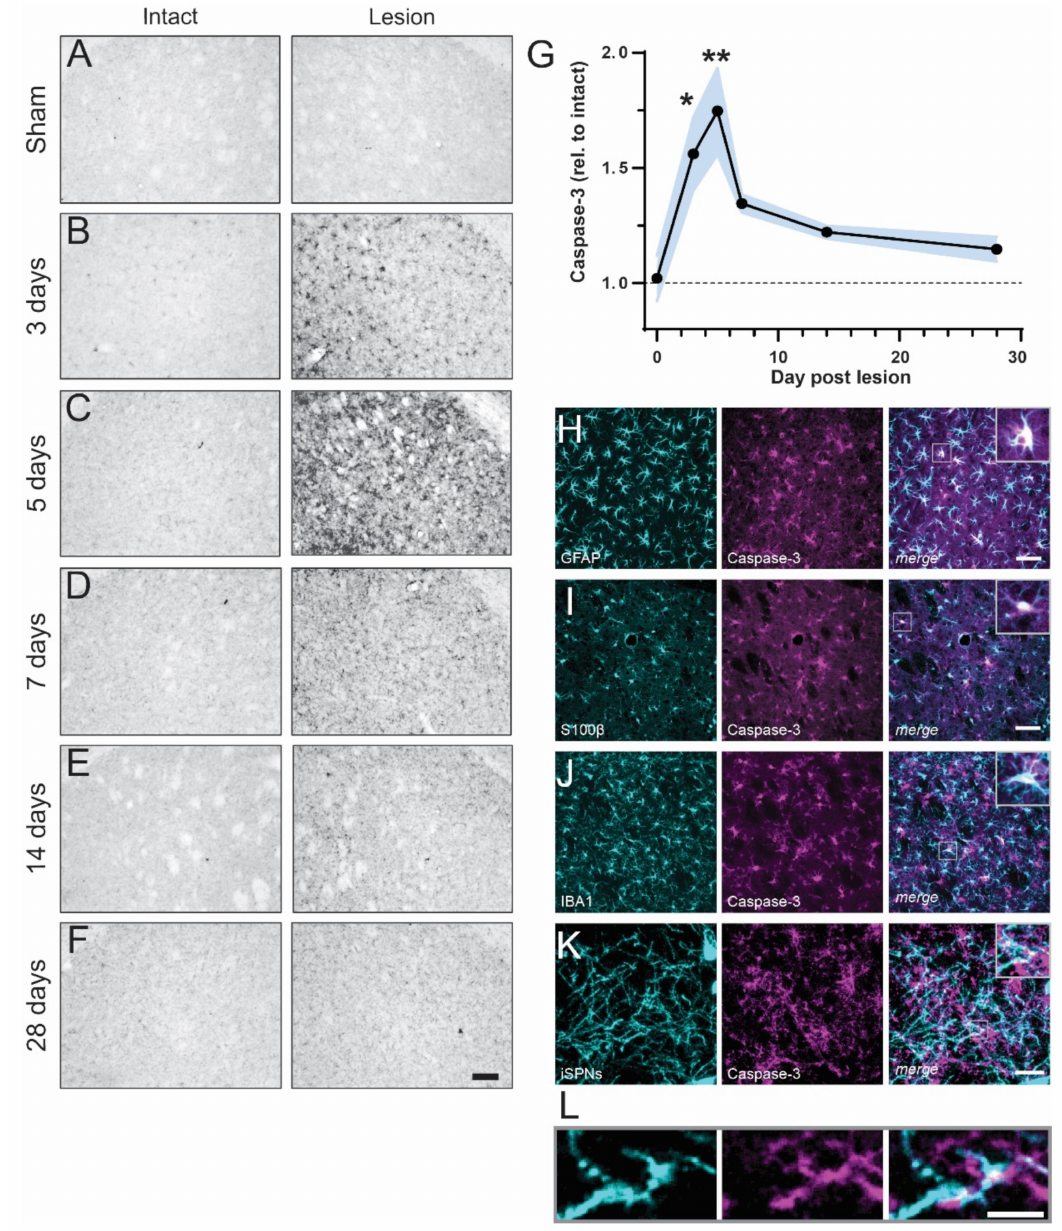
Figure 1. Caspase-3 is transiently upregulated in the DA-denervated striatum. ( A – F ) Striatal sections immunostained with a caspase-3 antibody depict the time course of caspase-3 activation in the DA-denervated striatum (right) relative to the control side (left) post 6-OHDA lesion. Scale bar: 100 µ m. ( G ) Densitometric analysis reveals an increase of caspase-3 levels in the DA-denervated striatum at three- and five-days post-lesion as compared to sham-lesioned animals (represented by “Day 0” datapoint). * p < 0.05, ** p < 0.01 vs. Sham, ANOVA and post hoc Bonferroni test, N = 4–7. ( H – K ) Dual-antigen immunostaining demonstrates caspase-3 co-labeling with markers for astrocytes (GFAP and S100 β ; H , I ), microglia (IBA1; J ) and iSPN dendrites (eGFP; K ). The latter were labeled using an AAV-based strategy (see methods). ( L ) Zoom-in of inset in ( K ) shows puncta of caspase-3 expression within iSPN dendrites. Scale bar: 20 µ m ( H – J ), 10 µ m ( K ), 3 µ m ( L